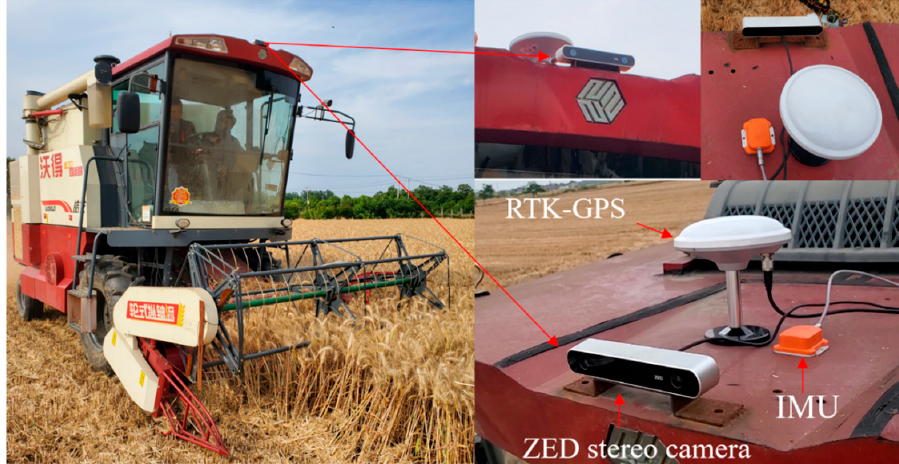
Figure 5. A schematic representation of the experimental platform, comprising a ZED stereo camera and RTK-GPS/IMU module as measurement instruments. A wheeled combine harvester was employed as a mobile platform.